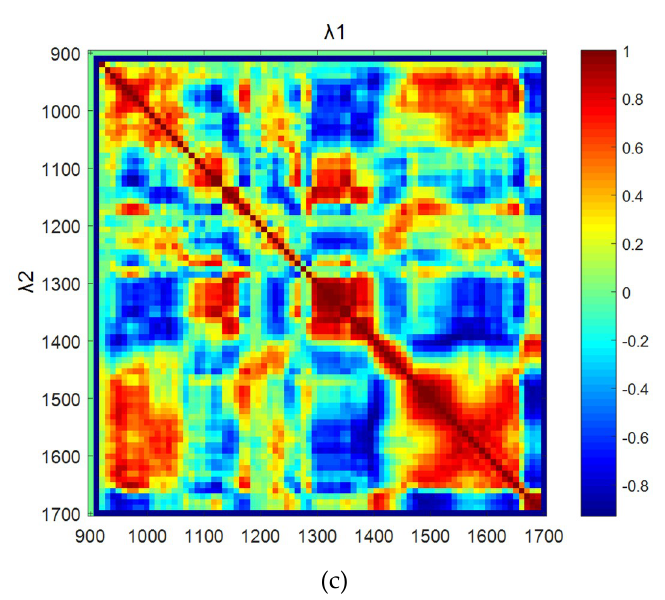
Figure 8. Autocorrelation coefficient of wavelengths. ( a ) RAW; ( b ) LOG; ( c ) DIFF.